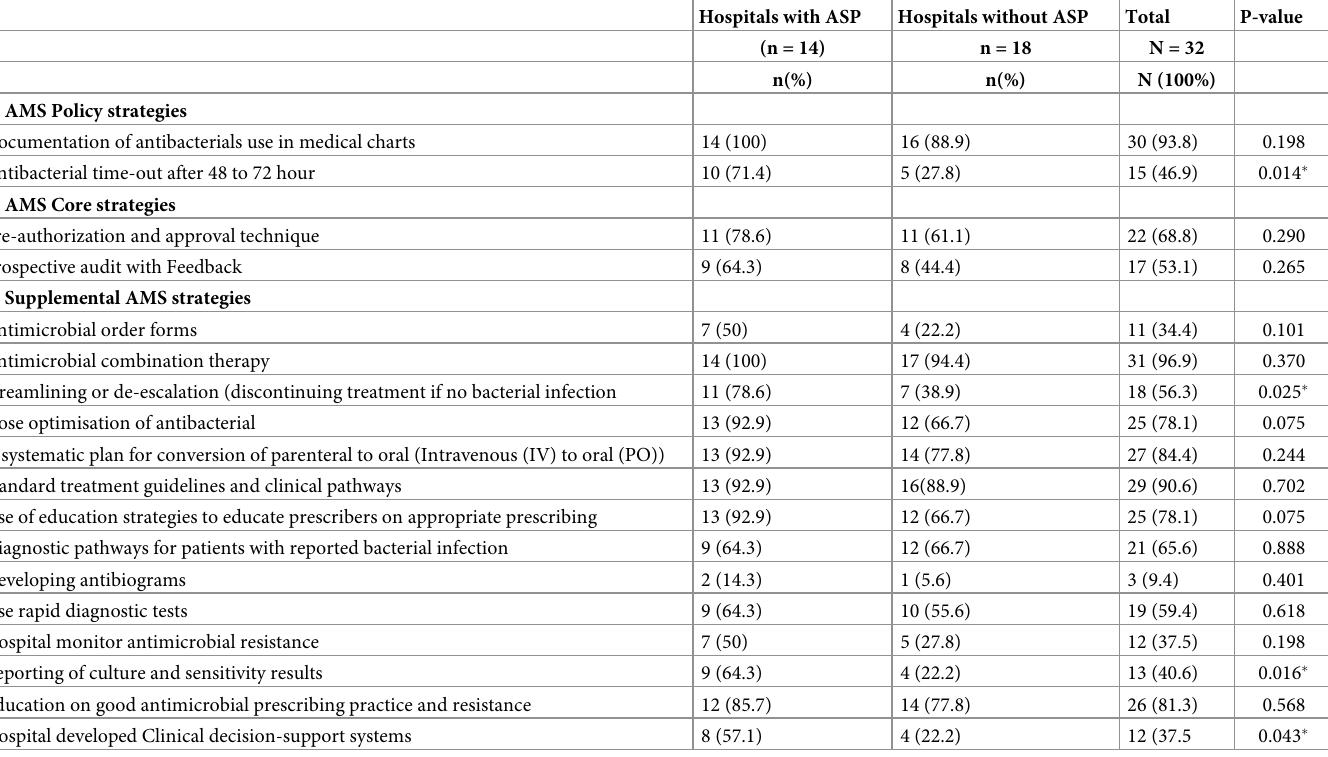
Table 3. Antimicrobial stewardship strategies reported in hospitals with or without ASP in Uganda (N = 32). Hospitals with ASP Hospitals without ASP Total